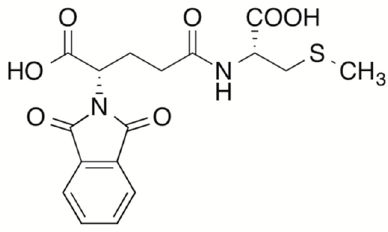
Figure 1. N -phtaloyl- -glutamyl- S -methyl- L -cysteine 12.